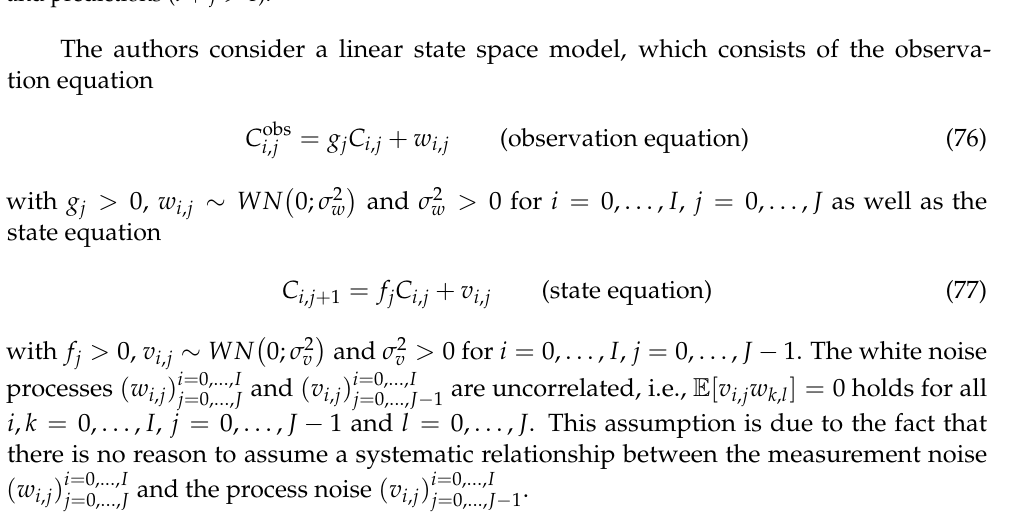
Figure 9. Unobservable states, observations and Kalman smoothings ( i + j < I ), filterings ( i + j = I ) and predictions ( i + j > I